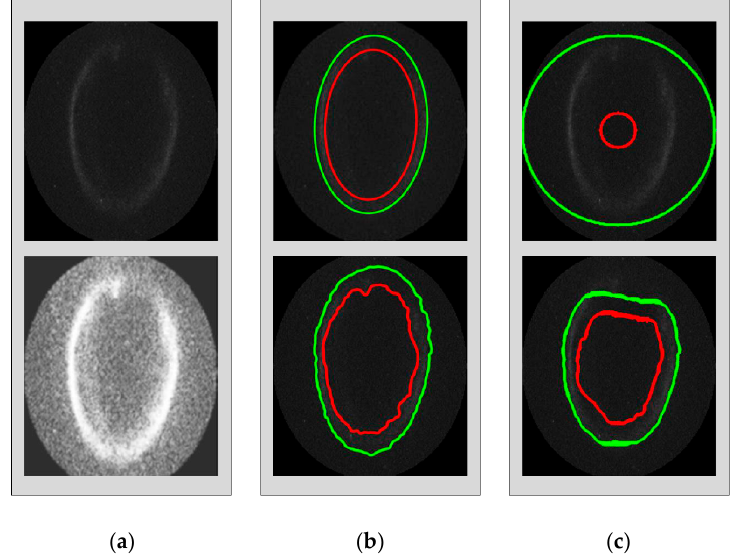
Figure 4. The auroral oval image and the local information based dual level set auroral oval segmentation method’s (LIDLSM’s) segmentation results obtained by different initializations. ( a ) The original auroral oval image (top) and image after histogram equalization (bottom) which can show the auroral structure more clearly. ( b ) The linear least square randomized Hough transform method (LLSRHT) based initialization (top) and segmentation result of LIDLSM (bottom). ( c ) The self-defined initialization that initial level set curves are far away from auroral oval boundaries (top) and low-precision segmentation result of LIDLSM (bottom).